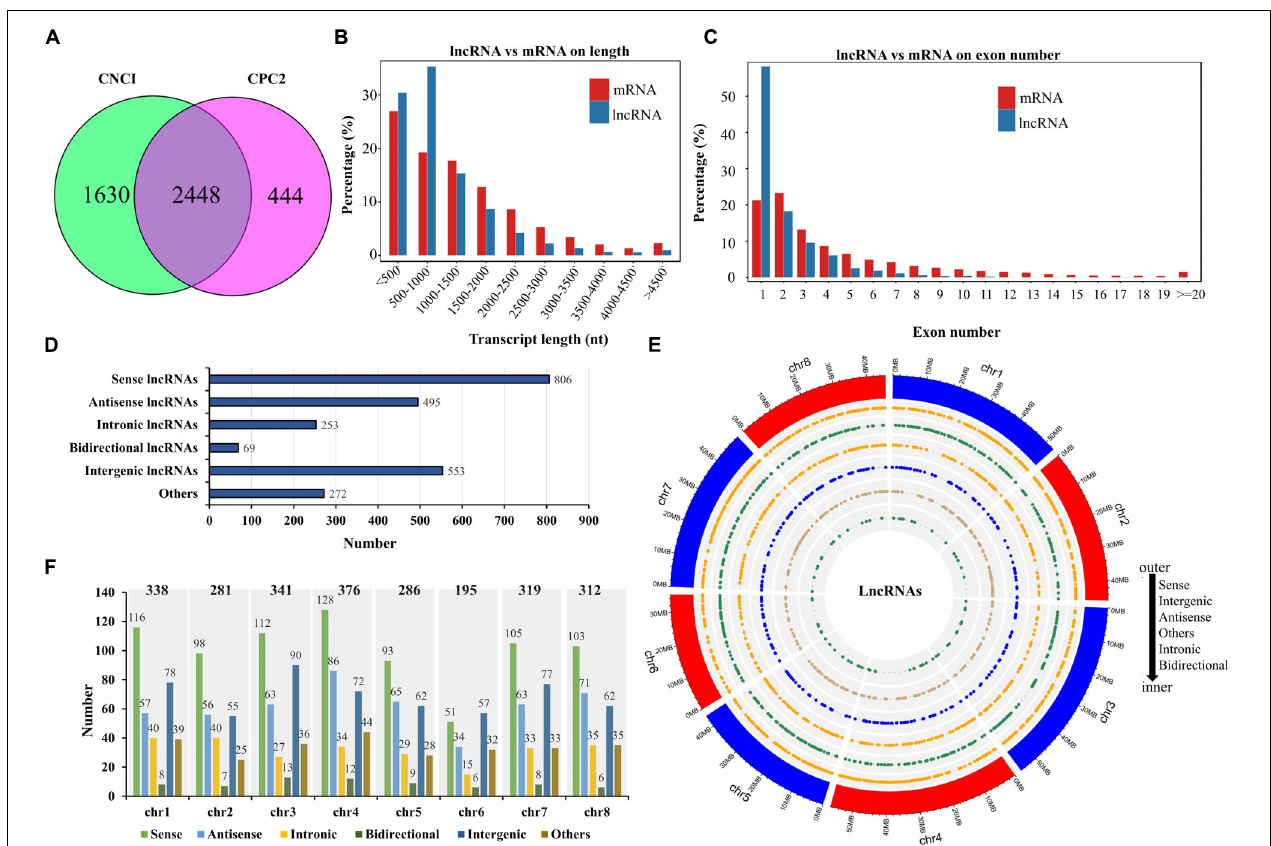
FIGURE 3 | Identification and distribution of lncRNAs. (A) The number of lncRNAs identified by the CNCI and CPC2 methods. (B) Comparison of lncRNA with mRNA in terms of transcript length. (C) Comparison of lncRNA with mRNA in terms of exon number. (D) Number statistics of different lncRNAs types. (E) Genomic distribution of different lncRNAs types. (F) Number statistics of different lncRNAs types on eight chromosomes.